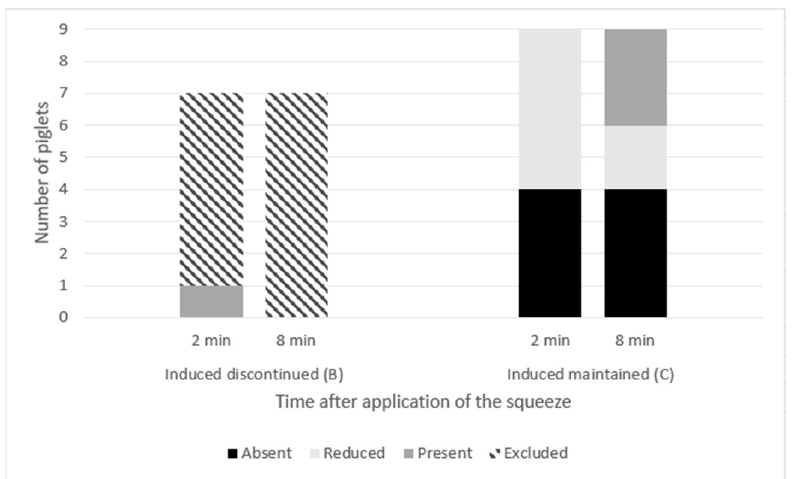
Figure 5. Pedal reflexes of Category B (induced discontinued, n = 7) and Category C (induced maintained, n = 9) piglets at 2 and 8 min after application of a thoracic squeeze. One piglet that was discontinued for physiological instability (Category D) is not included in the graph. Palpebral reflexes were similar with minor differences in responses for two piglets. Based on their similarities, only pedal reflexes are shown in the graph.